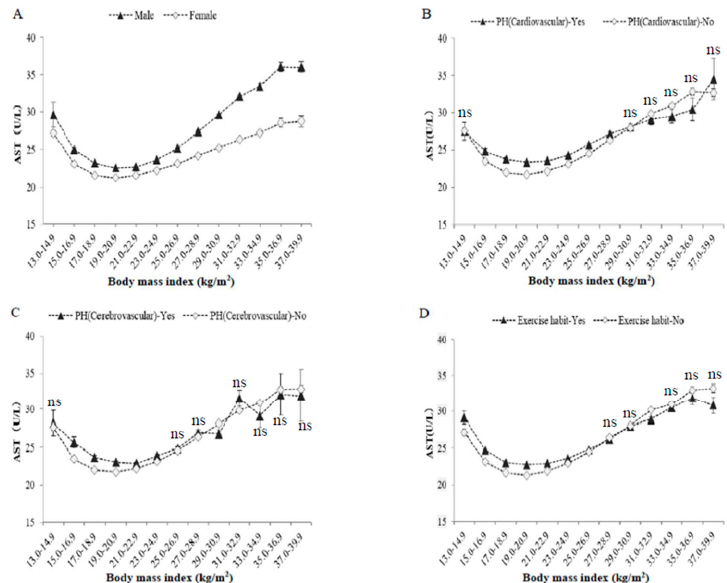
Figure 2. Raw serum AST activities, classified according to body mass index, sex, past histories, and exercise habit. The symbols indicate the mean values, and the vertical bars represent the 95% confidence intervals (CIs). BMI categories numbered 1–13 represent 13–14.9, 15–16.9, 17–18.9, cardiovascular diseases, ( C ) past history of cerebrovascular diseases, ( D ) habitual exercise ( ≥ 30 min per session, at least twice weekly). The number of subjects in each BMI category was the same as in Table 1 and Figure 1. The indication of ‘ns’ means no significant difference in values between two groups in each BMI category. Otherwise, a significant difference was observed